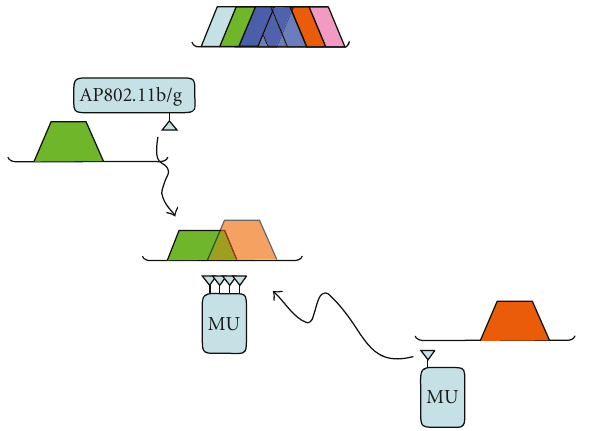
Figure 2: One multiband terminal receiving signals from one access point and one other mobile unit (MU) on overlapped channels. area networks (WPANs), wireless sensor networks (WSNs), or even body area networks (BANs).